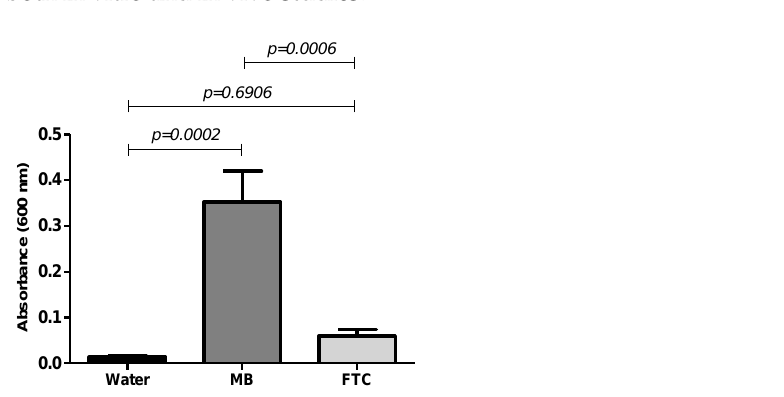
Figure 7. Means and SD of absorbance values (600 nm) in optical density values showing the ab- sorption of MB and FTC by the A. baumannii cells (ATCC 19606). (Water) A. baumannii in sterile distilled water only; (MB) A. baumannii treated with MB; (FTC) A. baumannii treated with FTC.